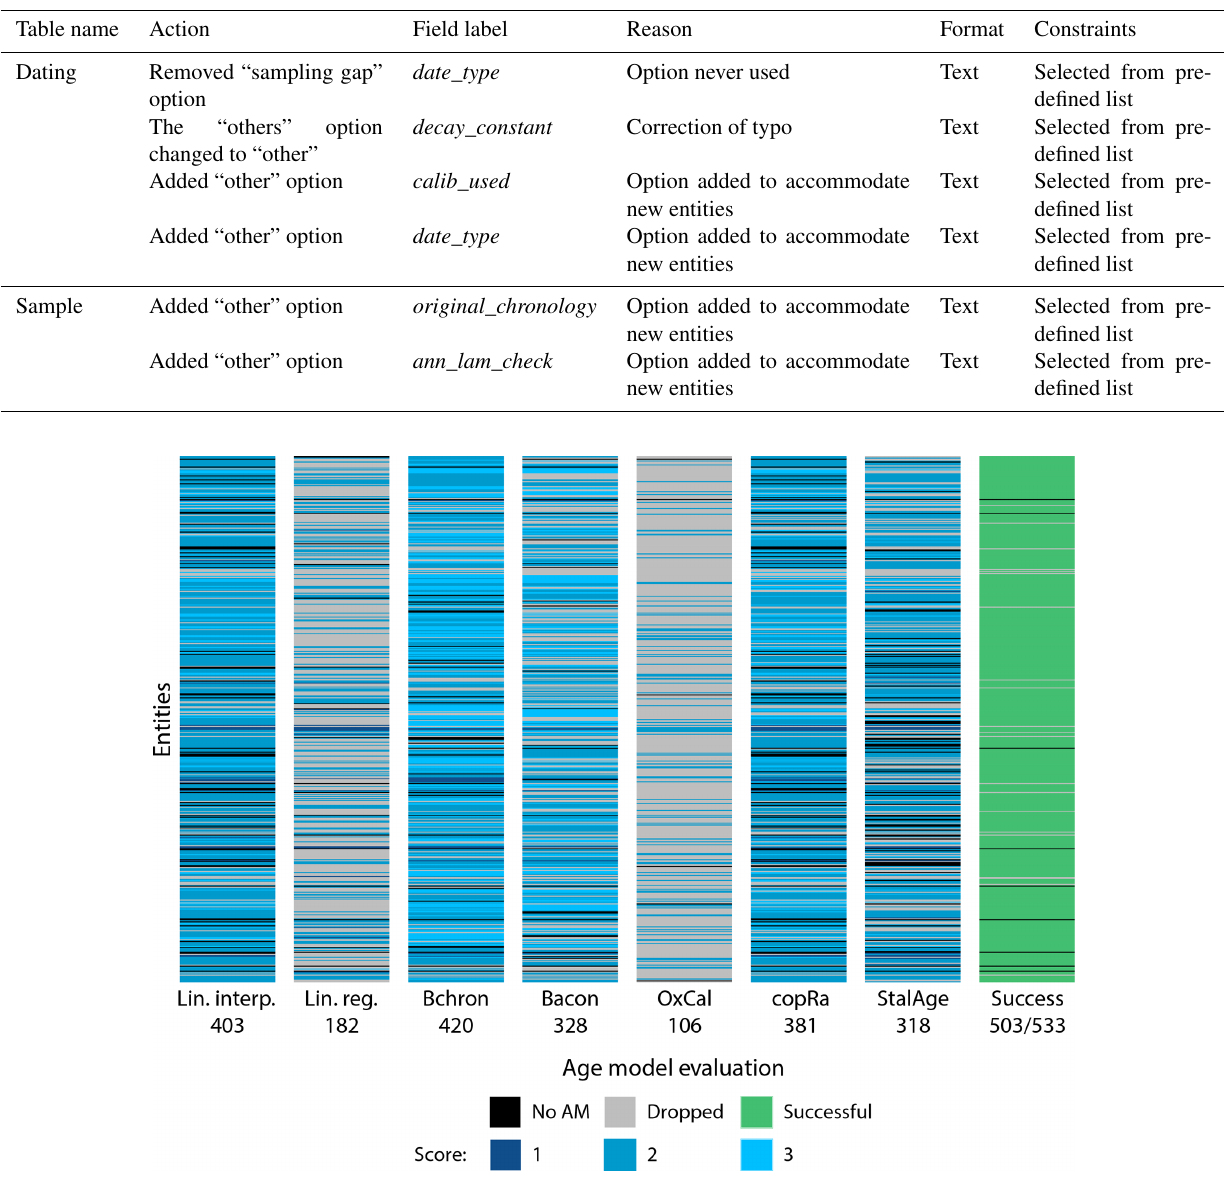
Figure 4. Visual summary of quality control of the automated SISAL chronology construction. The evaluation of the age–depth models for each method ( x axis) is given for each entity ( y axis) that was considered for the construction ( n = 533). Black lines mark age–depth models that could not be computed. Age–depth models dropped in the automated or expert evaluation are marked by grey lines. Age–depth models retained in SISALv2 are scored from 1 (only one criterion satisfied) to 3 (all criteria satisfied) in shades of blue. For 503 records alternative age–depth models with uncertainties are provided (green lines) in the “success”